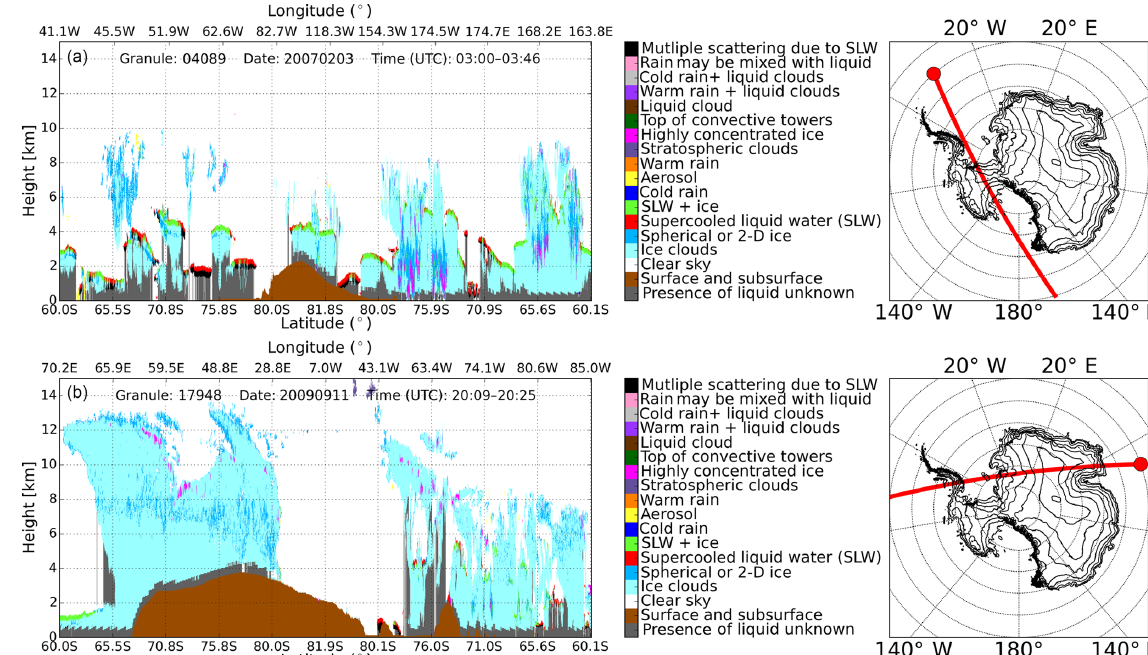
Figure 3. Two examples of DARDAR-MASK transects (altitude vs. latitude and longitude) illustrating the various categorisation included in the DARDAR-MASK version 2. The summer transect (a) occurred on 3 February 2007, while the early spring one (b) occurred on 11 September 2009. The small map next to each transect shows the satellite track (solid red line) projected over the Antarctic region. The circle indicates the beginning of the tracks across the